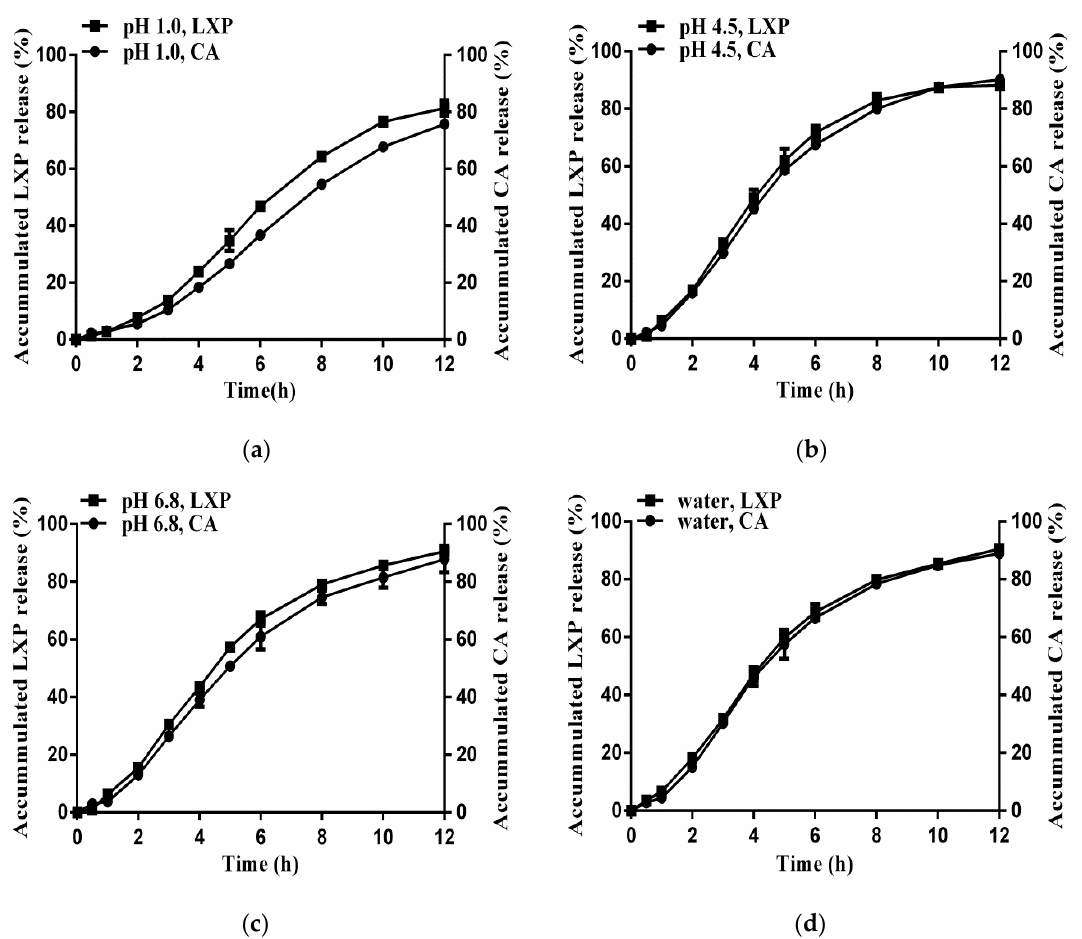
Figure 7. Loxoprofen and citric acid released from sustained release pellets in different dissolution media. ( a ) pH 1.0 HCl ( b ) pH 4.5 phosphate buffer ( c ) pH 6.8 phosphate buffer ( d ) water (means ± SD, n = 3).